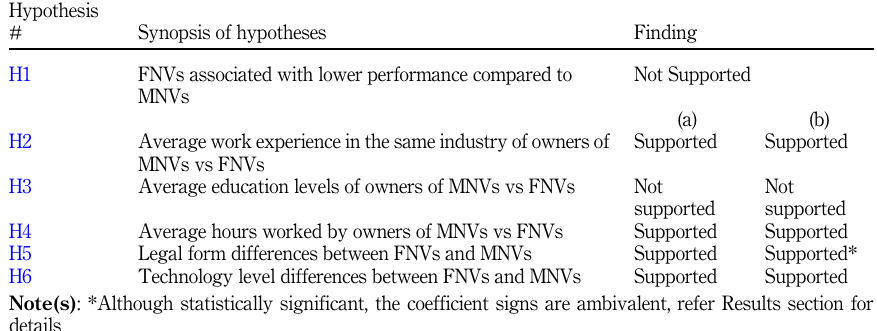
Table 6. Summary of